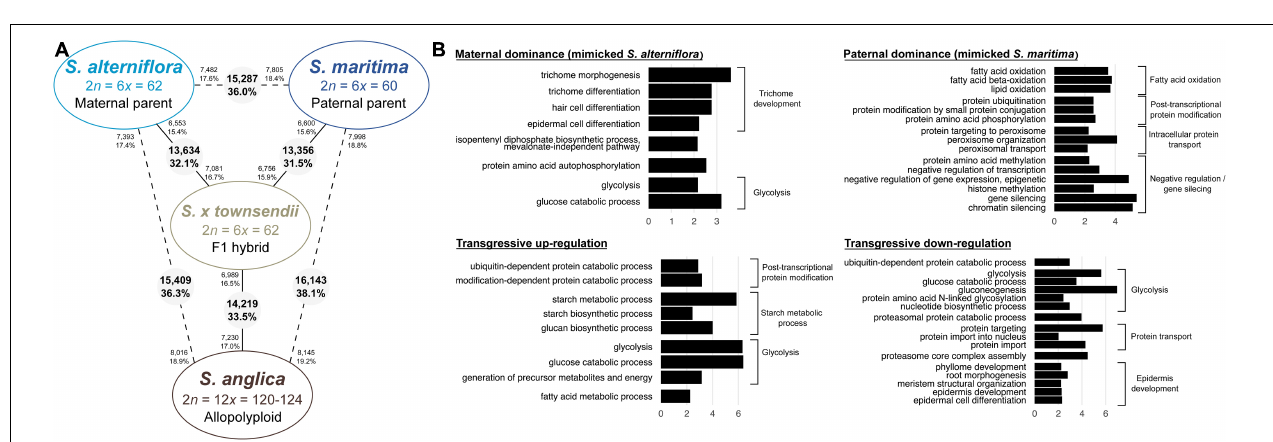
Frontiers in Genetics |